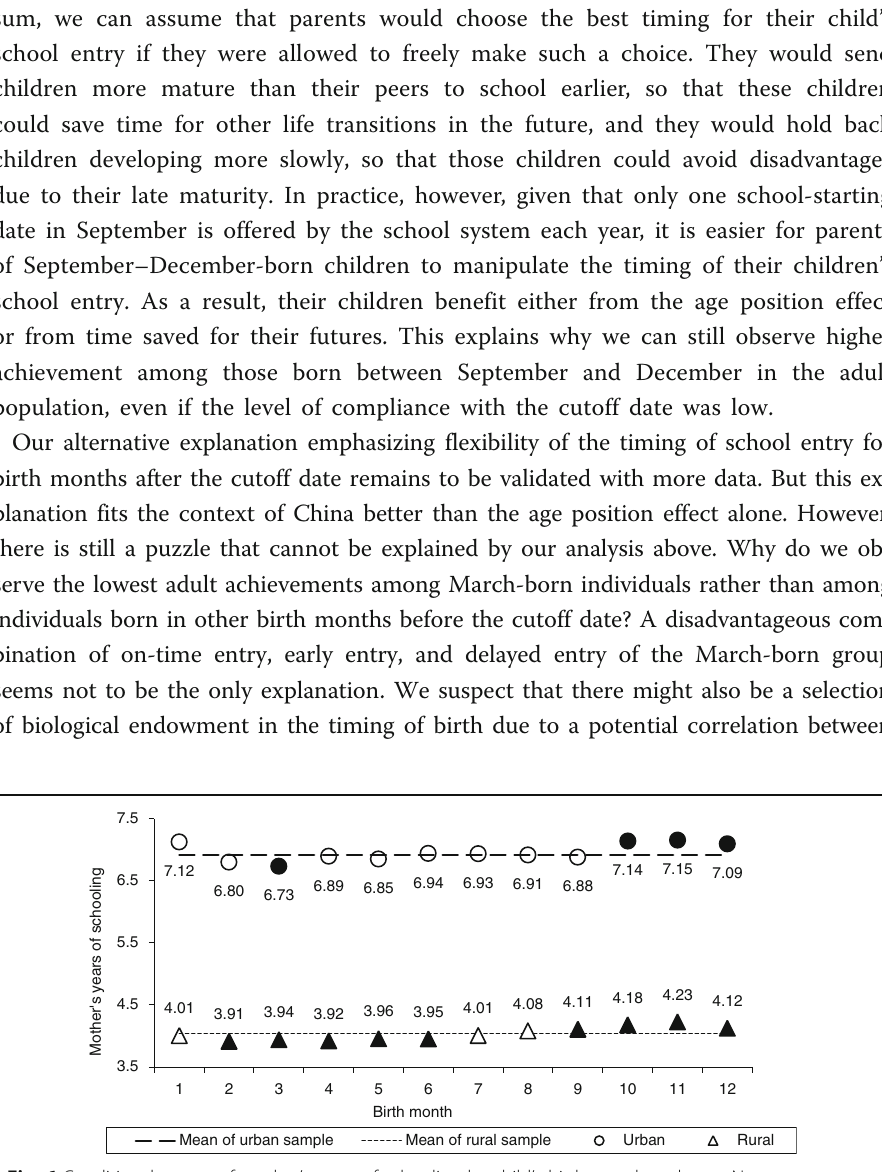
Fig. 6 Conditional means of mother ’ s years of schooling by child ’ s birth month and areas.Notes: Conditional means are predicted by an OLS regression model of mother ’ s years of schooling on child ’ s birth months (effective coding) for urban and rural samples separately. Dummy variables of child ’ s birth year and provinces are controlled in the models. A solid triangle or circle marker represents that the value significantly differs from the grand mean at a significance level of